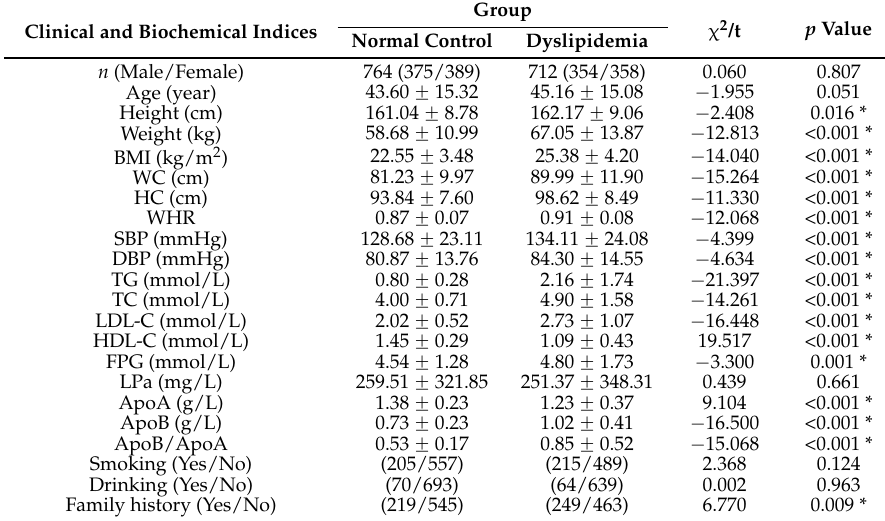
Table 1. Comparison of clinical and biochemical indicators across the normal control and dyslipidemia